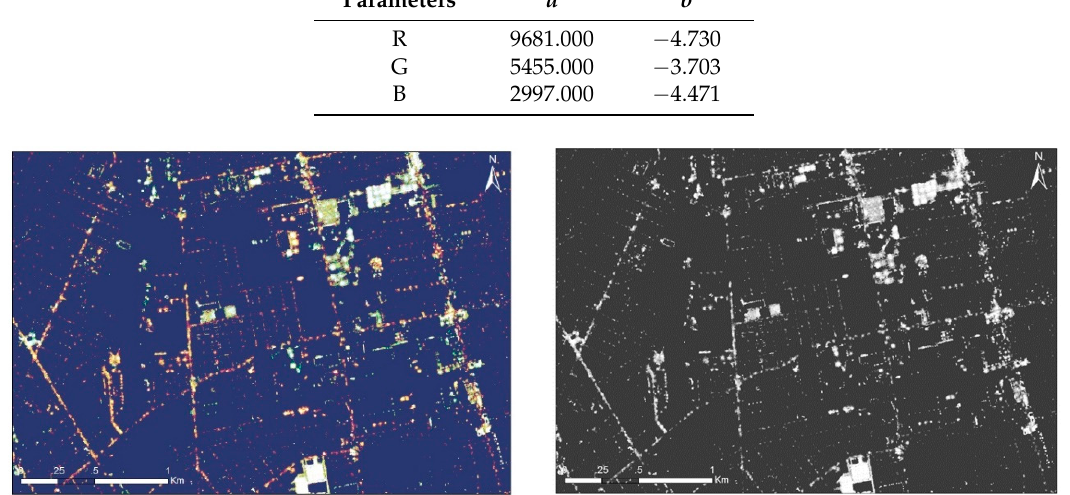
Figure 4. The RGB relative spectral response of the camera on the Jilin1-03 satellite. Table 2. The Jilin1-03 satellite parametric for converting DN value to radiance (Watts m − 2 sr − 1 ). Parameters